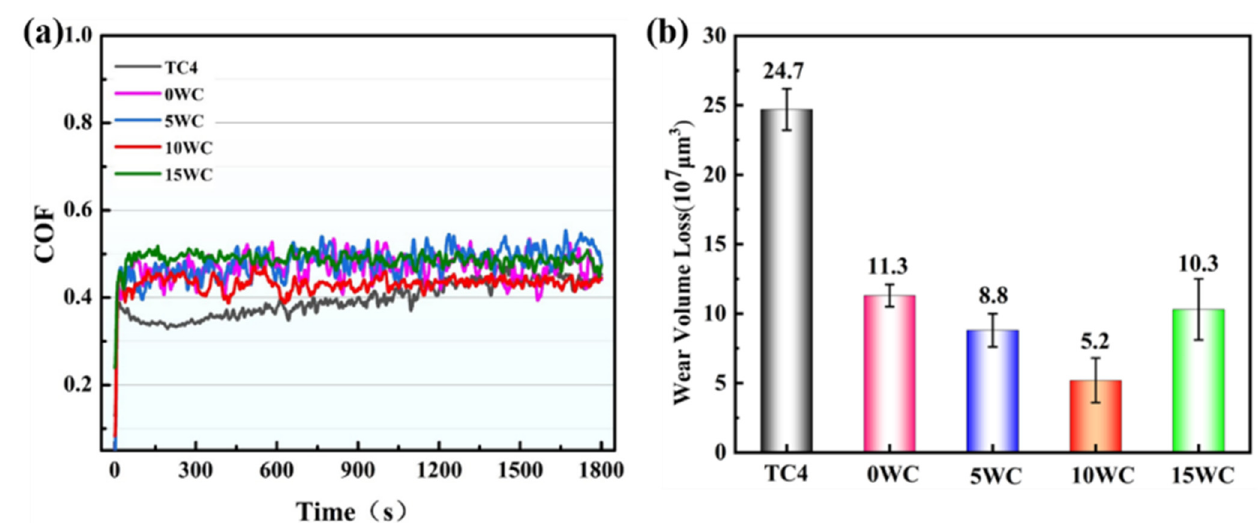
Figure 10. ( a ) Friction coefficient curves of the matrix and composite coatings. ( b ) Wear volumes of the matrix and composite coatings. the matrix and composite